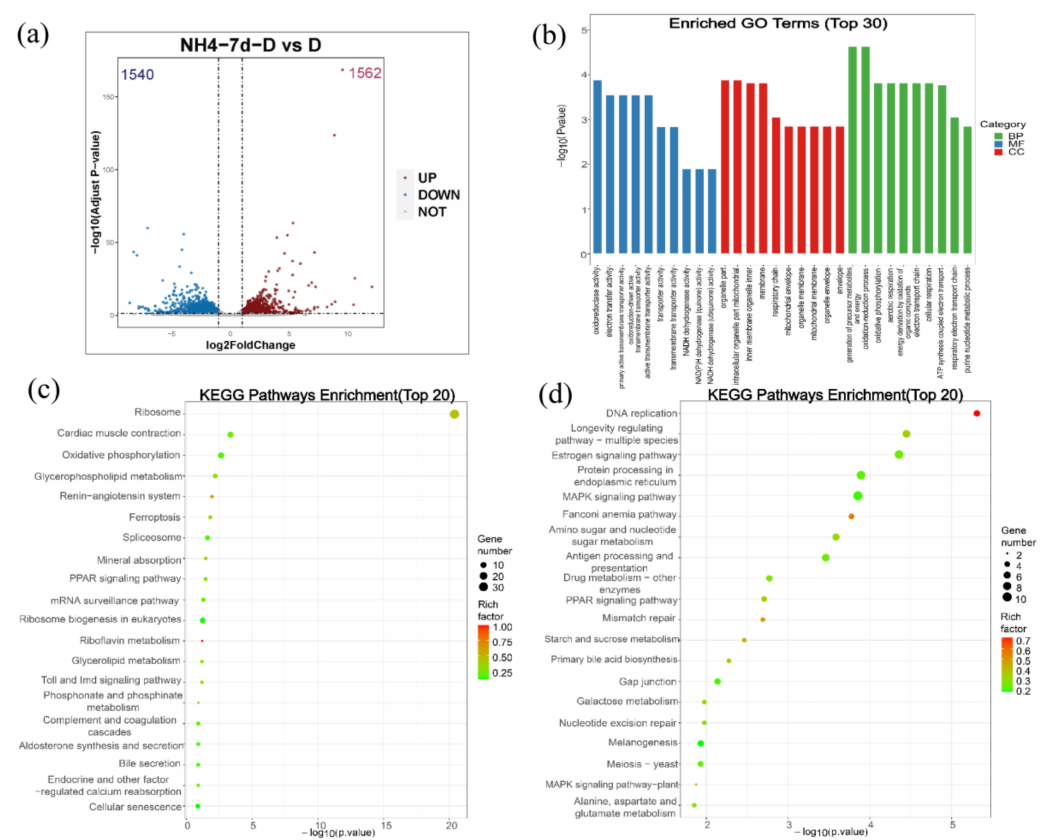
Figure 7. Analysis of the differentially expressed genes (DEGs) and GO enrichment and KEGG pathway analysis of DEGs. ( a ) Volcanic map shows the distribution of DEGs in the liver of largemouth bass after ammonia exposure for 7 days compared with the control group. Gray dots: genes with no significant difference, red dots: up-regulated genes with a significant difference, blue dots: down- regulated genes with a significant difference. ( b ) GO enrichment analysis of DEGs in largemouth bass liver after ammonia exposure for 7 days compared with control group. ( c ) KEGG pathway enrichment analysis of up-regulated DEGs. The size of the bubbles represents number of genes in a pathway, while the color represents rich factor. The X-axis represents − log10 ( p -value). ( d ) KEGG pathway enrichment analysis of down-regulated DEGs. The size of the bubbles represents number of genes in a pathway, while the color represents rich factor. The X-axis represents − log10 ( p